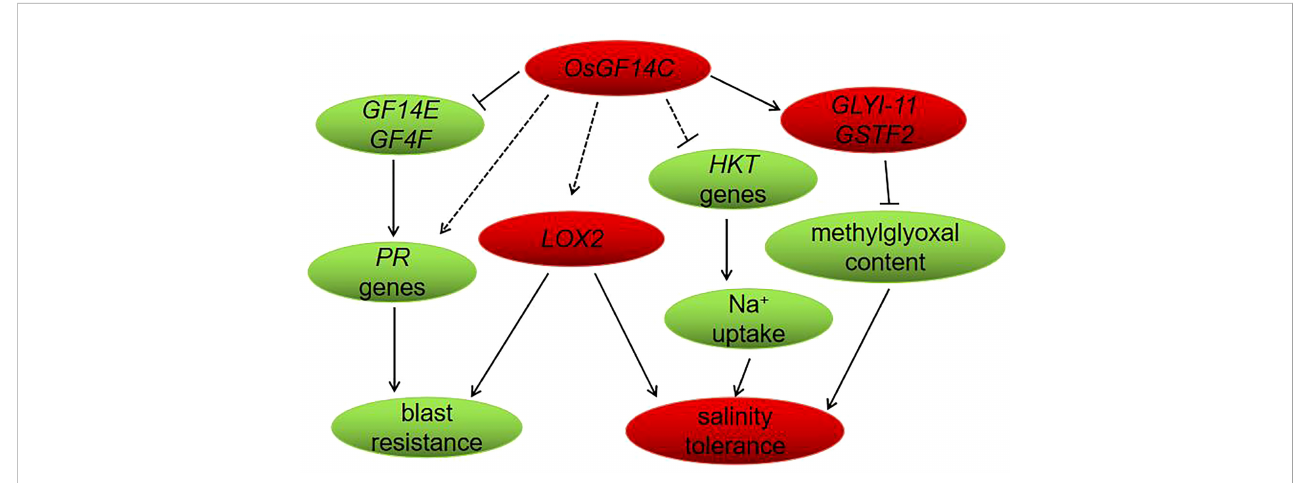
FIGURE 9 Proposed model of OsGF14C in salinity tolerance and blast resistance in rice. When the expression level of OsGF14C is up regulated, the expression of GF14E , GF14F , PR genes, and HKT genes were repressed, while the expression of GLYI-11, GSTF2 , and LOX2 were